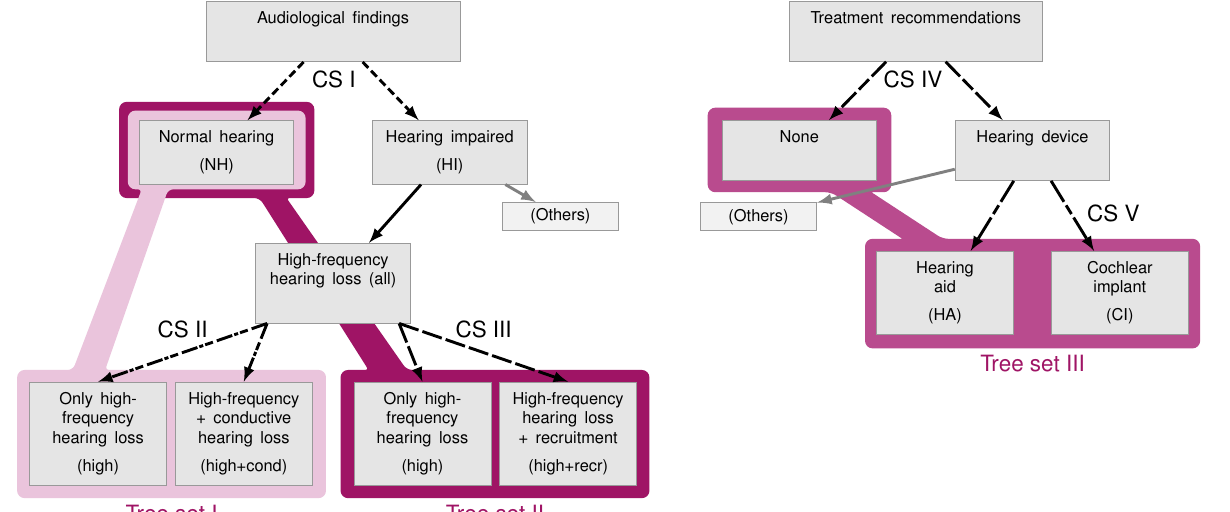
Figure 2. Schematic representation of comparison sets (CS) and tree sets. Different arrow line styles belong to different comparison sets of two respective categories, as described in [31,32]. Different colors show the comparison of categories performed in the respective tree set, which were derived by combination of comparison sets. Abbreviations as introduced in parentheses are used throughout the paper. This figure was adapted from Figure 2 of